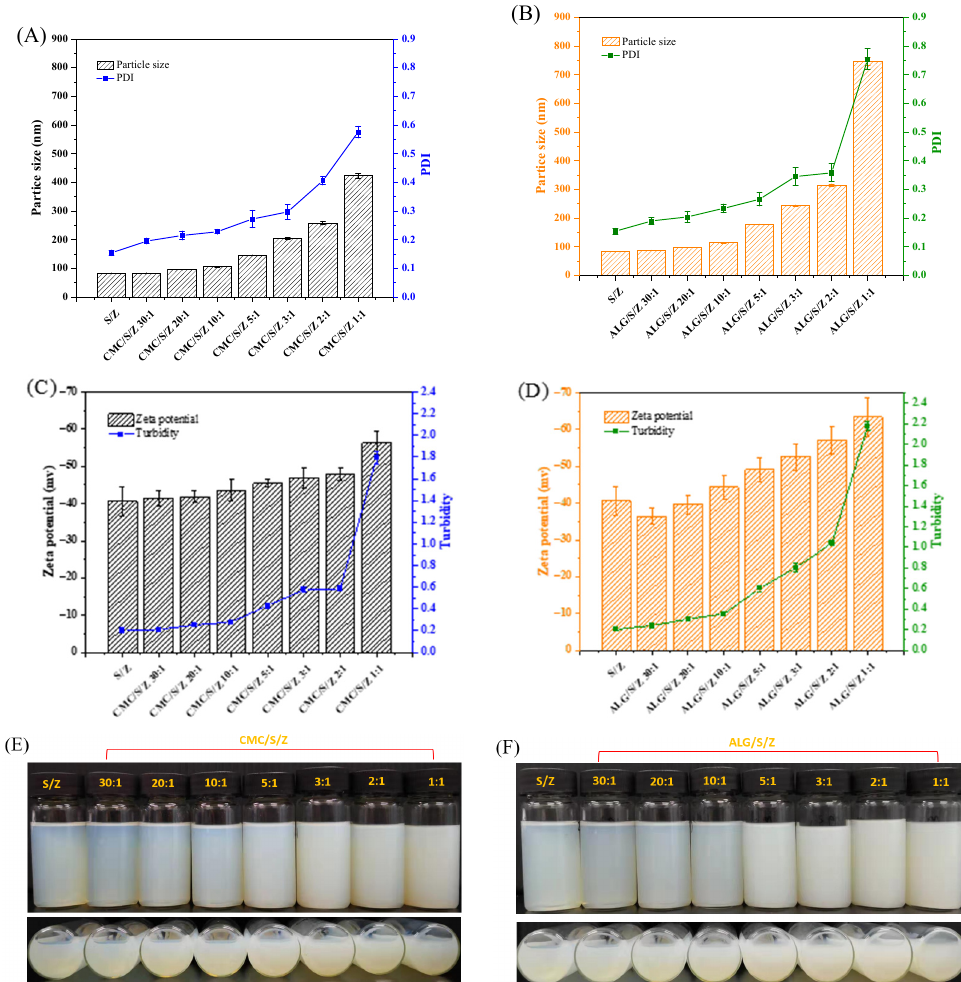
Figure 1. Particle size, PDI, zeta potential and turbidity of CMC/S/Z and ALG/S/Z with different zein to polysaccharide mass ratios. Particle size and PDI ( A , B ). Zeta-potential and turbidity ( C , D ). The photograph of each group appearance ( E , F ).